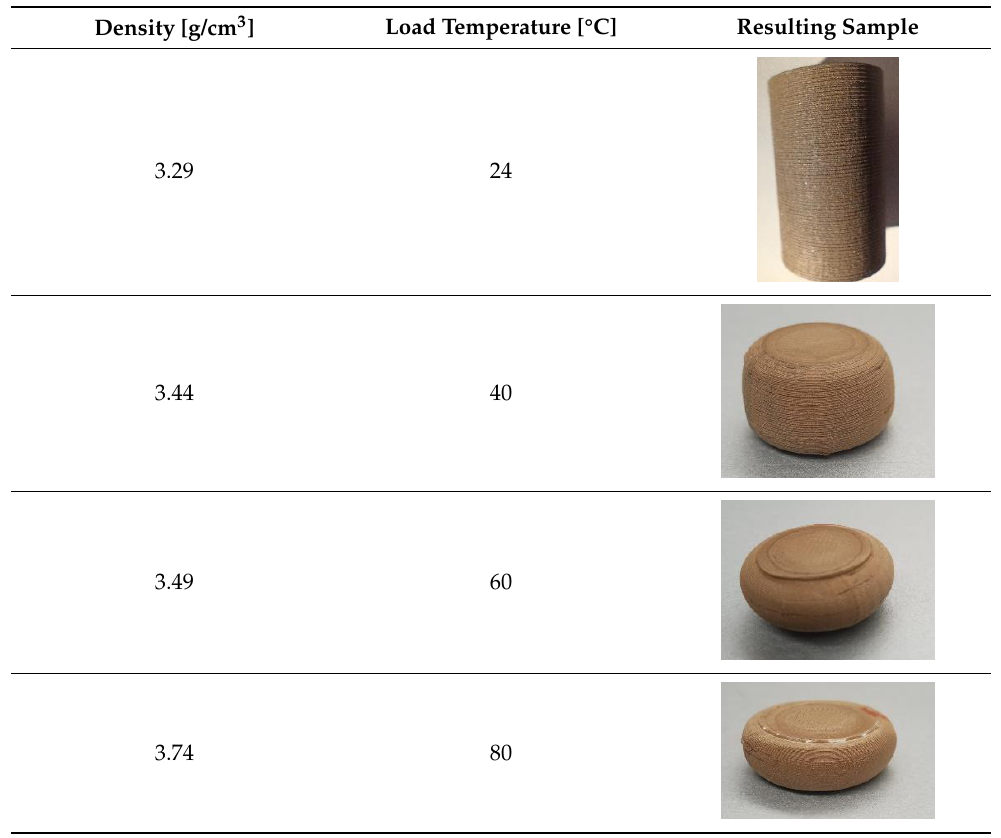
Figure 12. Experimental results for vertically layered printed samples: engineering compressive stress versus compressive strain at different temperatures. Table 2. Samples density versus temperature at 3000 N load for vertically layered printed samples.